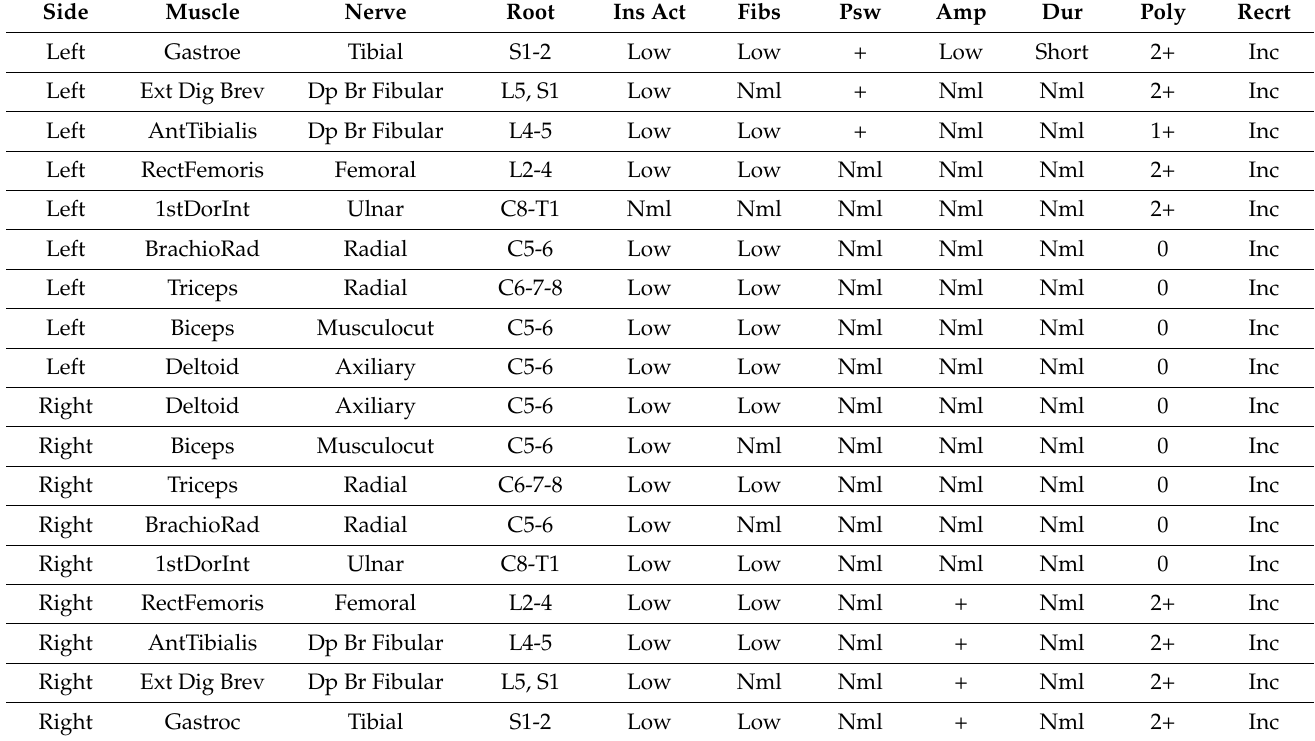
Table 1. The electromyographic study shows data of chronic and active partial denervation in the indicated myotomes (low).